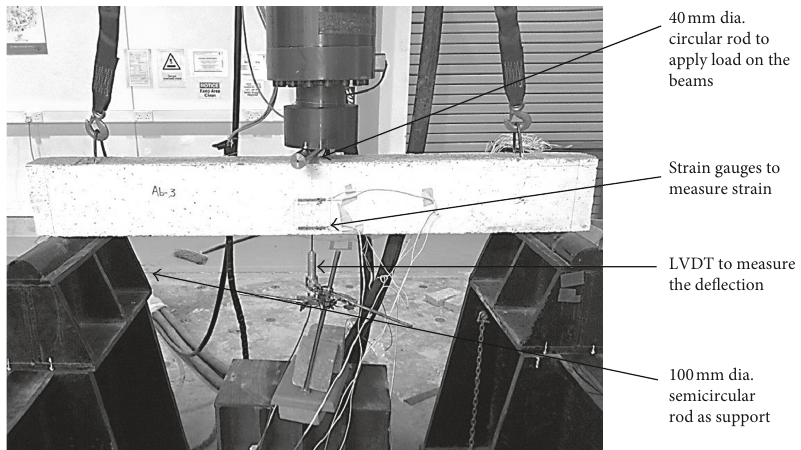
Figure 5: Typical loading arrangement of beams